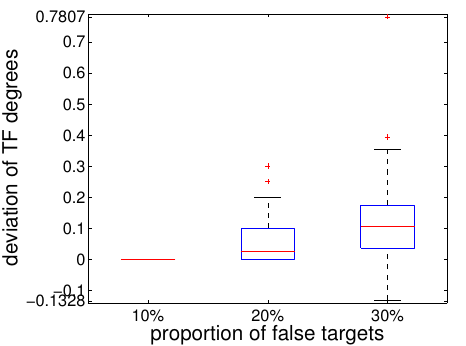
Figure 10. Distributions of deviation of TF degrees in sampling dataset with false targets from that without false